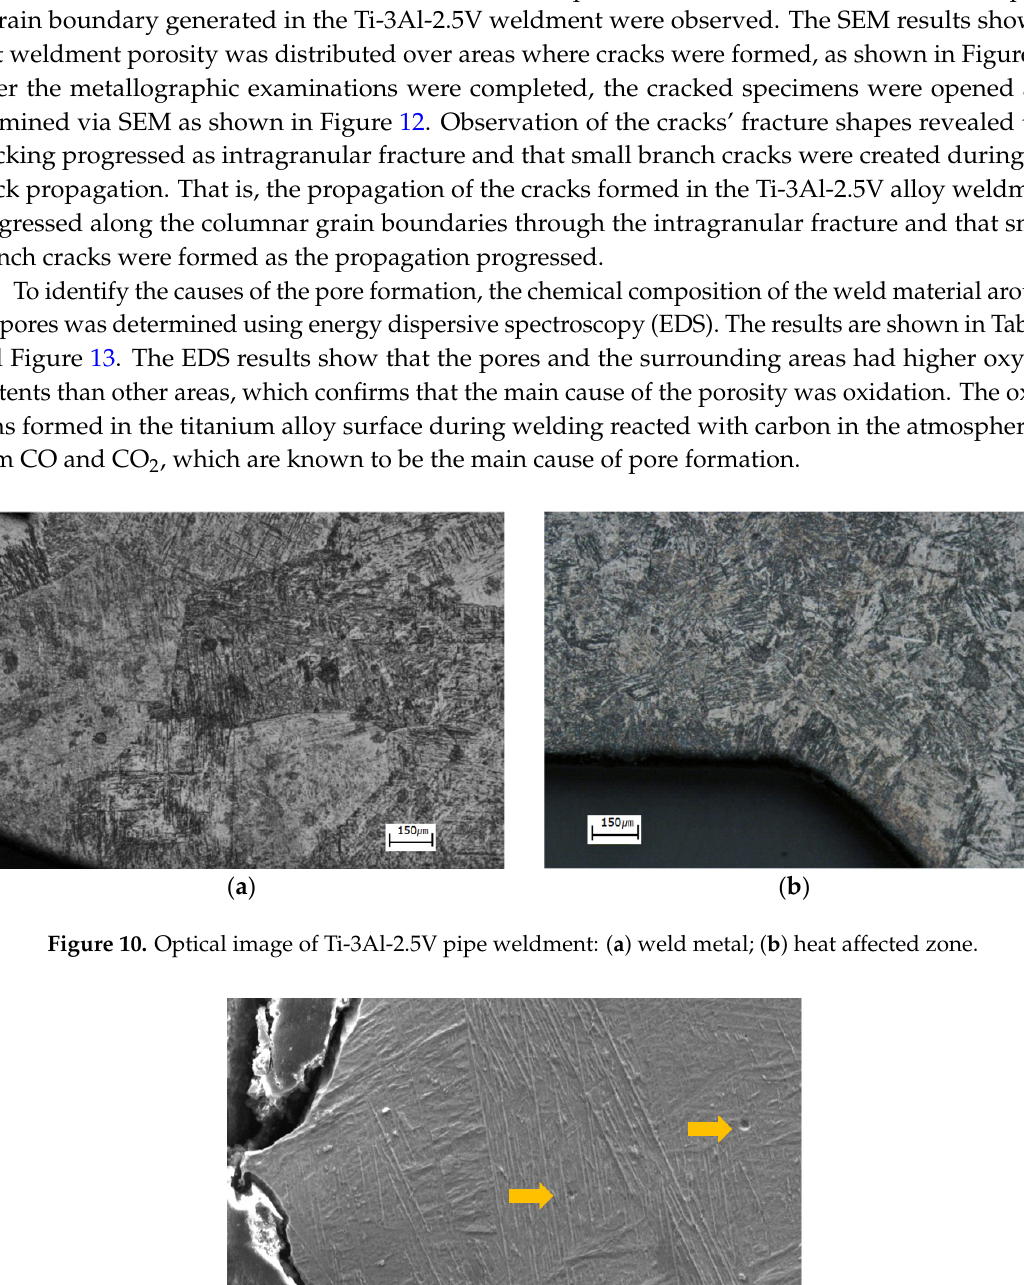
Figure 9. Results of the NSR (notch tension strength ratio).